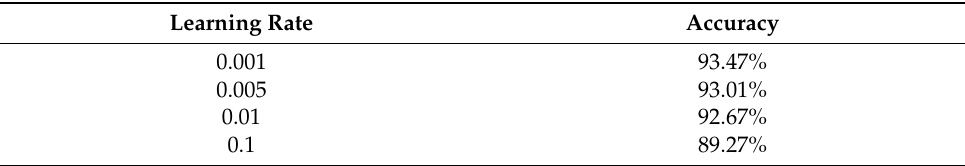
Table 7. Accuracy of different learning